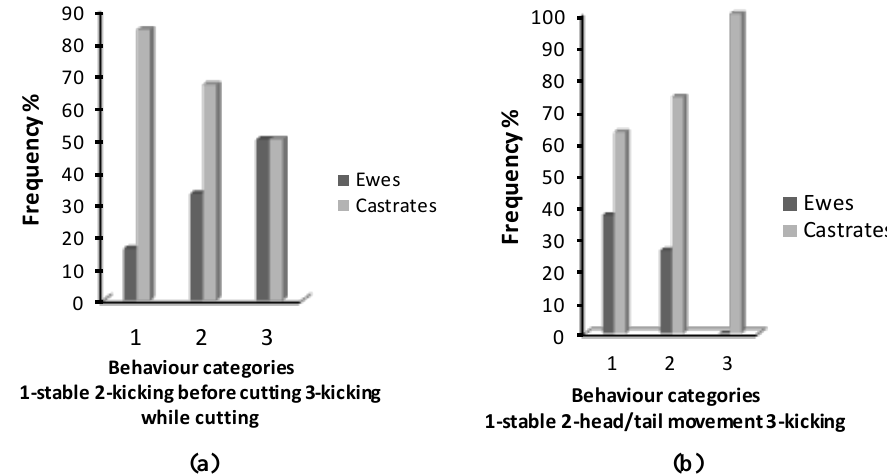
Figure 3. Frequencies of gender in animal avoidance-related behaviour categories after stunning and during